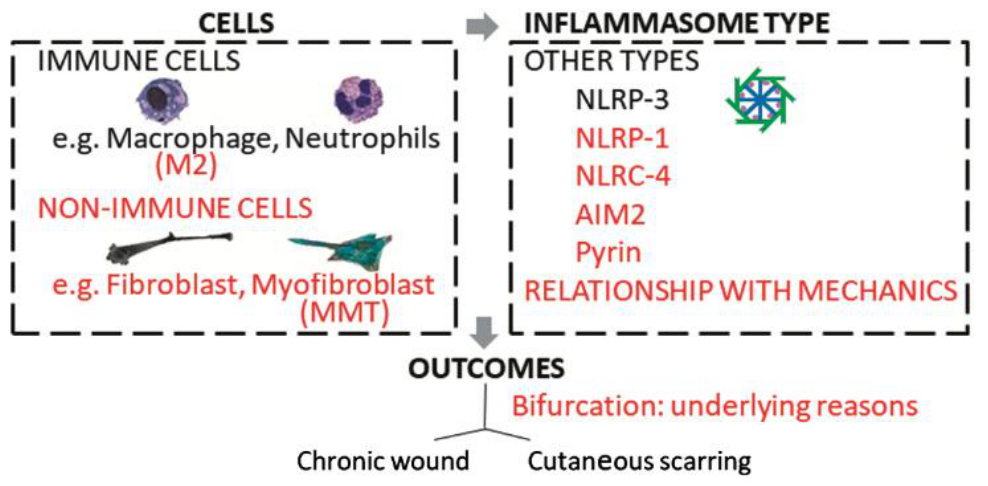
Figure 4. Future directions in research on the roles of inflammasomes in pathological scarring. What is currently known is marked in black: thus, NLRP3 and immune cells such as macro- phages and neutrophils may participate in pathological scarring. What should be researched to im- prove the field is marked in red: what is the role of M2 cells in keloids? Is the inflammasome also important in non-immune cells such as (myo)fibroblasts? Does MMT link M2 macrophages, inflam- masomes, and myofibroblastic activity? Can non-canonical inflammasomes contribute? How do these elements relate to mechanical signaling? [Abbreviations — AIM2: absent in melanoma 2; MMT: macrophage-to-myofibroblast transition; NLRP: nucleotide-binding oligomerization domain, leu-